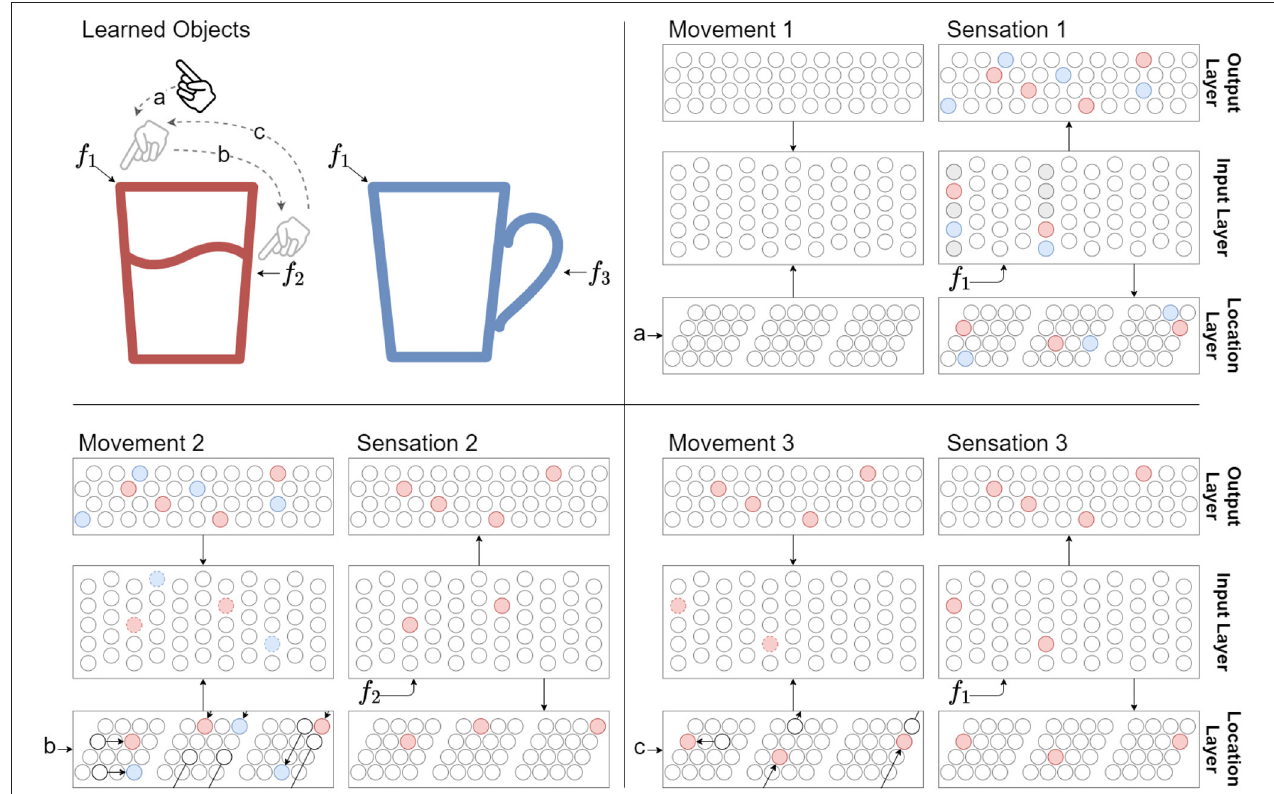
FIGURE 2 | The sensorimotor sequence of a sensor moving across a known object (red glass) is used to recognize the object. Features f 1 , f 2 , and f 3 represent sensory input when the sensor senses at their respective locations. The distance between these features are traversed by motor commands a, b, and c, which is also used as an input to the network. Cell activity colors are matched to object colors, and connection colors to Figure 1 . Three movements and sensations are shown to a network that have already learned the two objects. Movement 1: There is no network activity after the first movement command because the network didn’t have a previous location representation. Sensation 1: The first sensation of feature f 1 causes all cells in the respective mini-columns to activate, since none of the cells were predicted. Note that f 1 has been learned on two objects, thus there are two representations (red and blue) in the input layer for the sensed feature at the current location. These activations drive the two object representations to become active in the output layer, as well as two location representations. Movement 2: The location layer performs path integration in response to motor input b on both its location representations. The activity bumps are shifted according to module scale and orientation. The input layer receives modulatory input from the location layer through its basal connections and from the output layer through its apical connections. Note that the top-down expectations are applied on the predictions from path integration. In this simple example these expectations agree with the aforementioned predictions. This modulatory input predicts both f 2 and f 3 for the next sensation. Sensation 2: After sensing f 2 , only the predicted cells in the respective mini-columns become active. This in turn drives a single object representation in the output layer to become active, as well as a single location representation. The network has